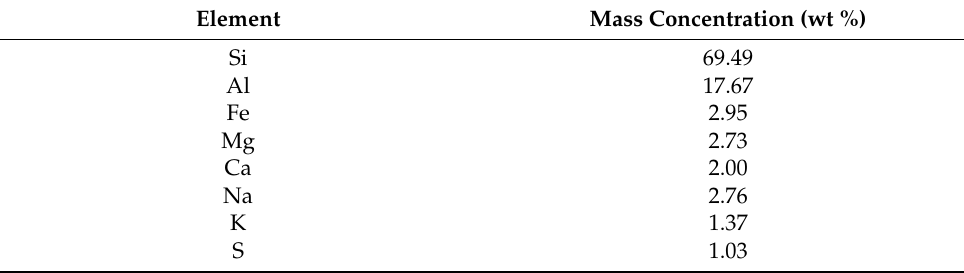
Table 3. Chemical composition of activated sodium bentonite by